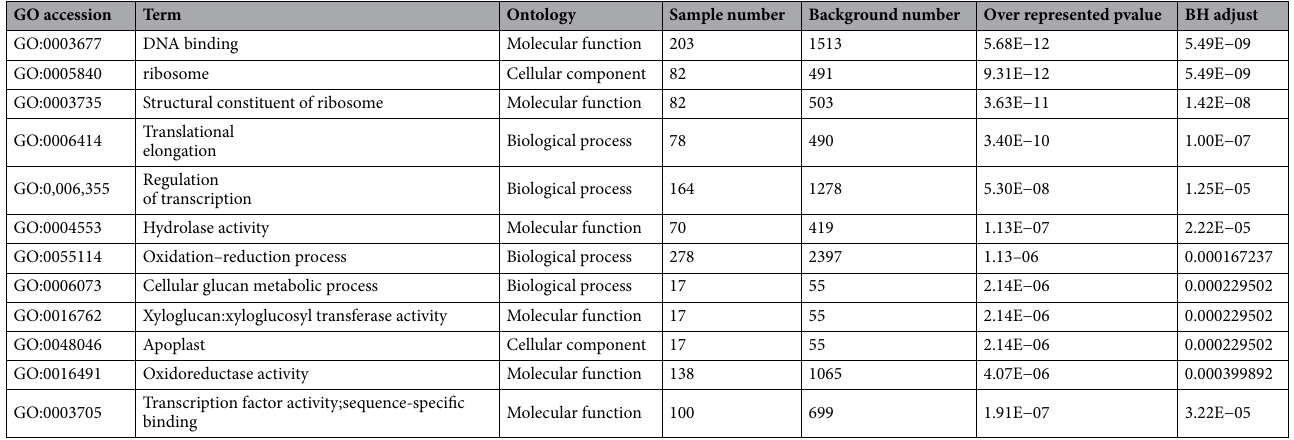
Table 4. 12 GO items with the most significant enrichment.